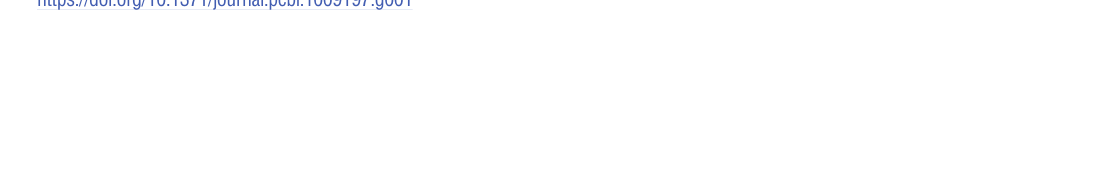
PLOS Computational Biology | https://doi.org/10.1371/journal.pcbi.1009197 July 28,